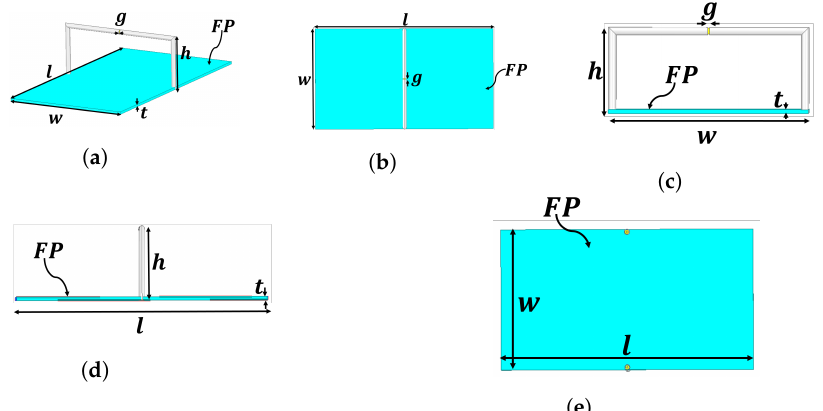
Figure 4. FLA structure, where aqua color (region of l × w × t ) is Ferrite Plate (FP) and other parts are shielded coaxial cable RG405. ( a ) perspective view, ( b ) top view, ( c ) side view, ( d ) front view, and ( e ) bottom view. Dimensions in mm are, l = 100, w = 56, h = 22, t = 1.1, and g = 0.5 .